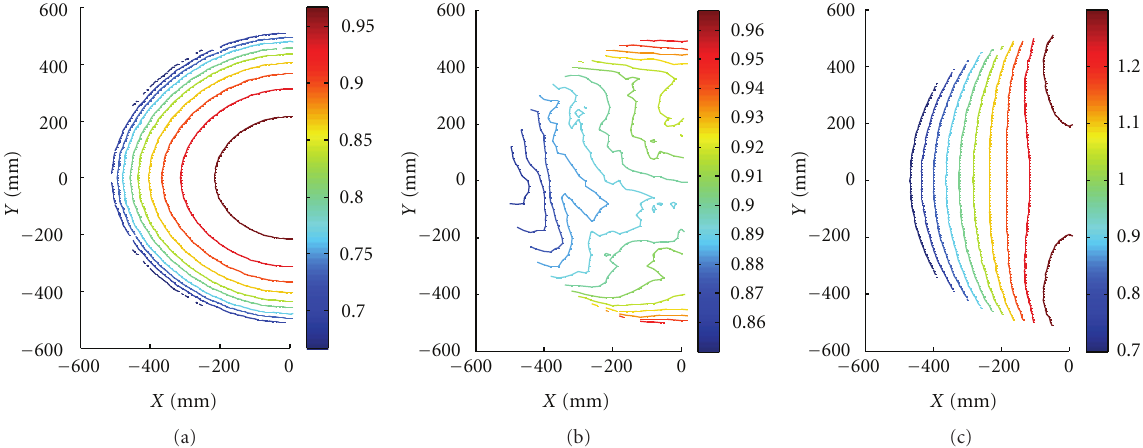
Figure 18: Manipulability index μ t (a), normalized velocity along the X direction (b), and DSI μ X computed in the horizontal half-plane XY with Z = − 1050 mm